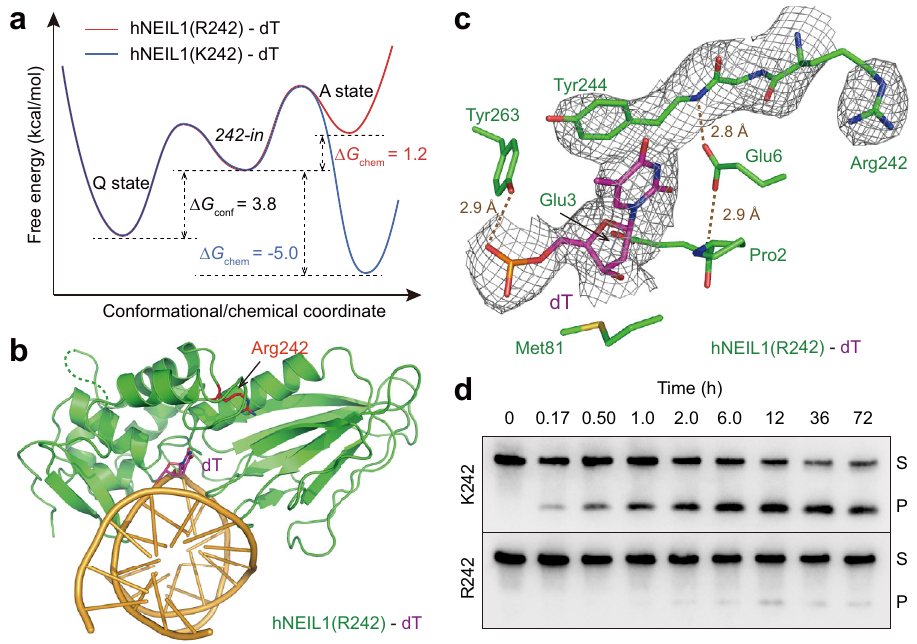
Fig. 5 The interrogation of normal base by hNEIL1. a The free energy pro fi le of state transition for hNEIL1(R242) and hNEIL1(K242) bound to a mismatched dT. b Overall structure of hNEIL1(R242) bound to double-strand DNA containing a T:C mismatch. The fl ipped dT is colored with purple and Arg242 is shown in red. c Zoom-in view of the interactions between dT and hNEIL1(R242). A quarantine state similar to that identi fi ed in the crystal structures of hNEIL1(R242) in complex with (F)DHU or DHT is also observed here. The 2Fo − Fc simulated-annealing composite omit electron density map is shown in gray mesh and contoured at 1.0 σ . d An electrophoretic assay shows the glycosylase activities of unedited hNEIL1(K242) and edited hNEIL1 (R242) on a T:C mismatch. The experiment was repeated three times independently with similar results. Source data are provided as a Source Data fi le. Detailed quantitative results can be found in Supplementary Fig.